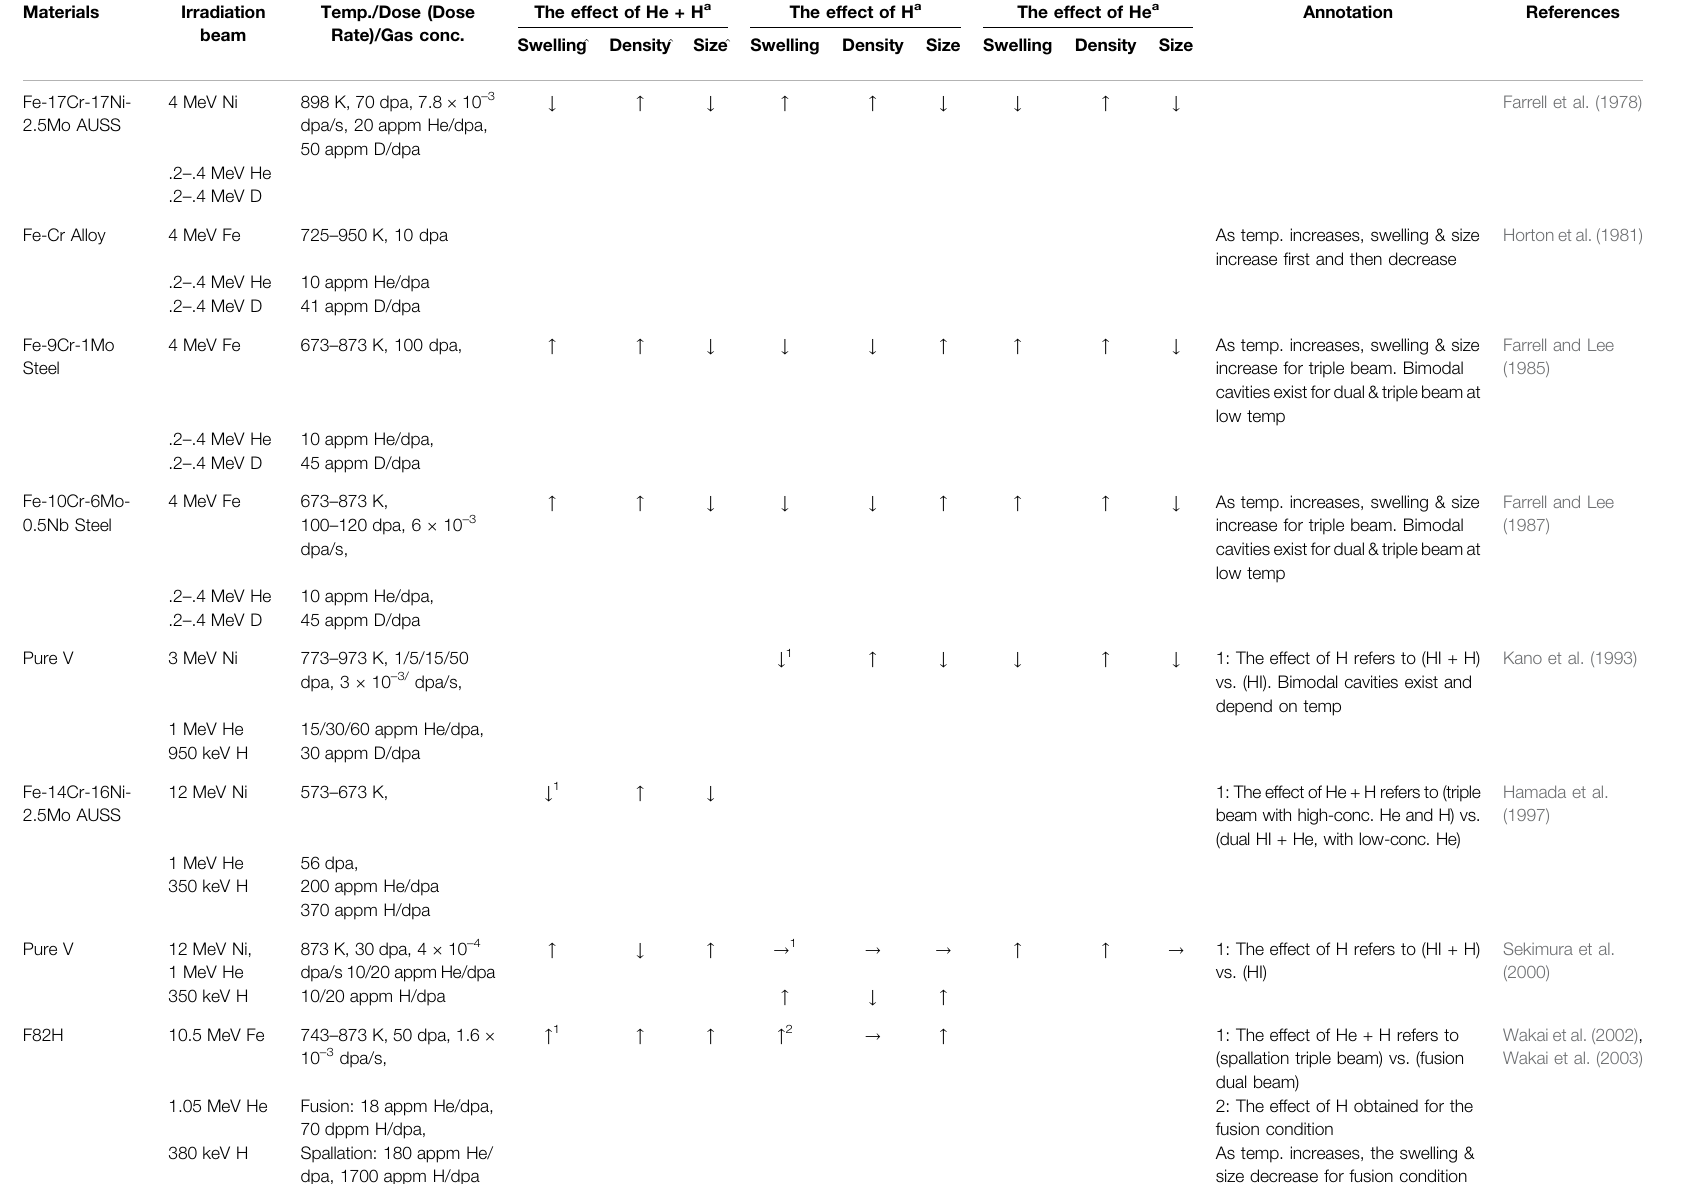
TABLE 1 | The summary of typical studies on the He-H synergistic effects under multi-ion beam irradiation.